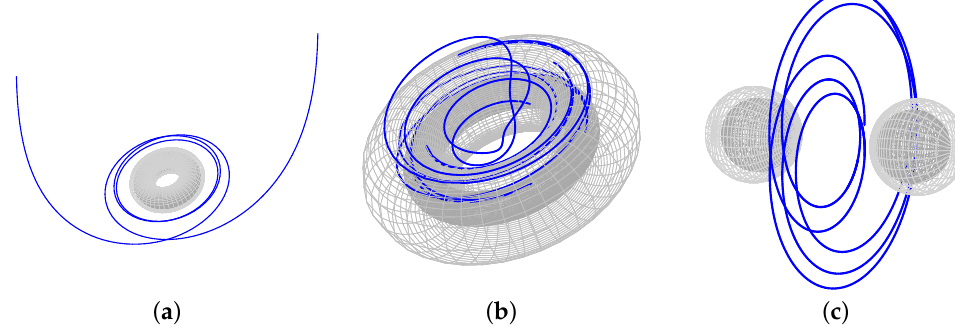
Figure 2. Orbits of particles (blue curves) around the black ring. The horizons are depicted as grey tori or spheres. ( a ) Escape orbit in the equatorial plane ( x = ± 1); ( b ) Many-world bound orbit in the case E = m = 0; ( c ) Bound orbit in the plane of ψ -rotation ( y = −